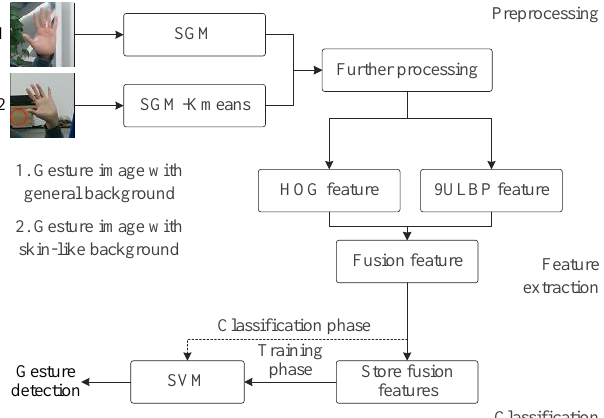
Figure 1. The framework of the proposed gesture recognition method.